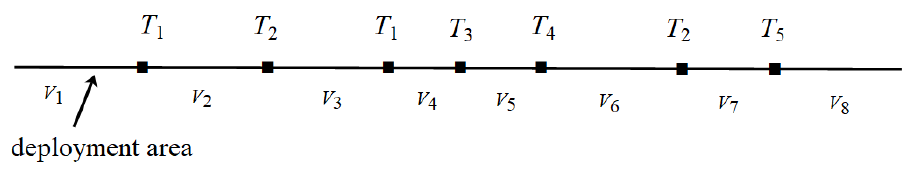
Figure 18. The transmitter placement order and their receivers’ placement areas.